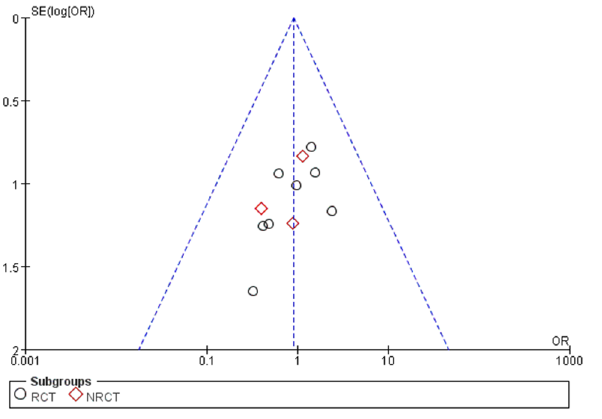
Figure 4. Funnel plot of comparison the